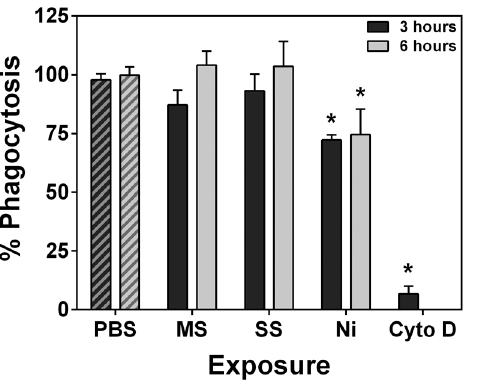
Figure 6. Pre-incubation with Ni-Cu WF impairs phagocytosis. RAW 264.7 cells were treated with 50 m g/ml welding fume suspensions for 3 or 6 h or cytochalasin D (Cyto D) for 3 h. Cells were washed, pHrodo Red E. coli BioParticles were added for 2 h, and plates were read to measure changes in fluorescence. Error bars represent the mean 6 SD (n=4). *, p , 0.05 compared to PBS controls.